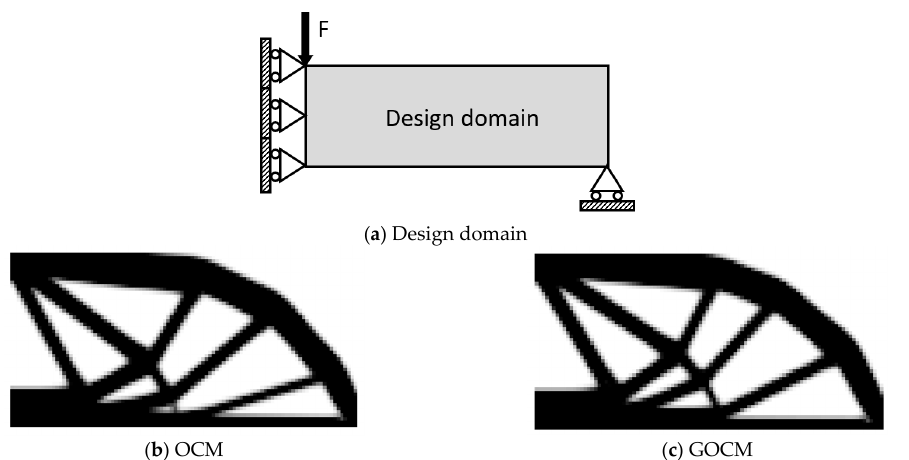
Figure 2. Design domain and optimum designs of a cantilevered beam.